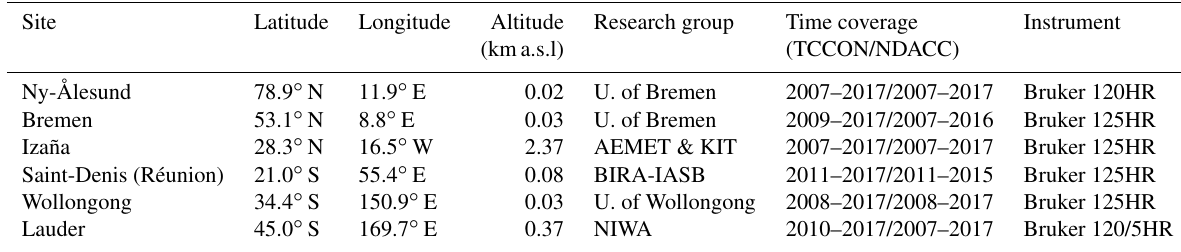
Table 1. The coordinates, responsible institute and time coverage of measurements at six sites used in this study. Site Latitude Longitude Altitude Research group Time coverage Instrument (kma.s.l) (TCCON/NDACC) Ny-Ålesund 78.9 ◦